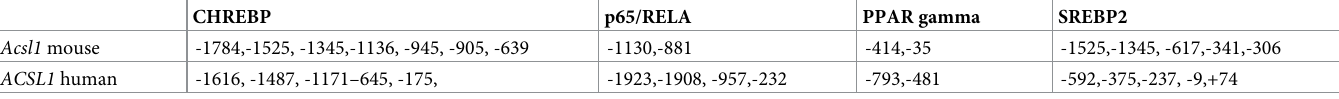
The p-value used for the motif prediction was p < 0.001.